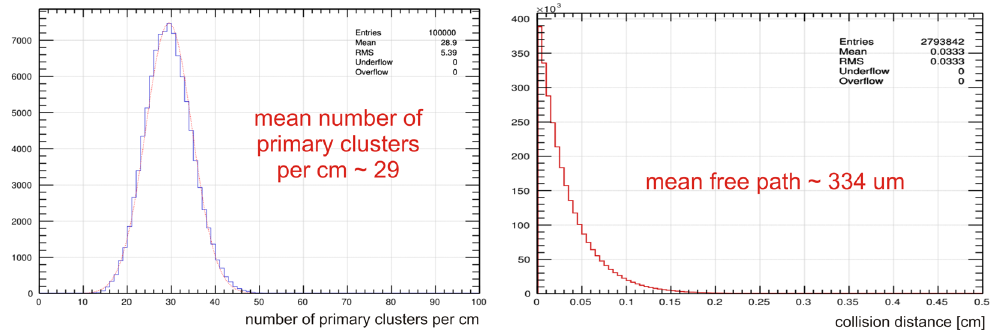
Figure 5. (Left) Distribution of primary electron-ion clusters along 1 cm of the track for the particle pi + with initial momentum 1 GeV / c; (right) distribution of collision distances for the particle pi + with initial momentum 1 GeV /